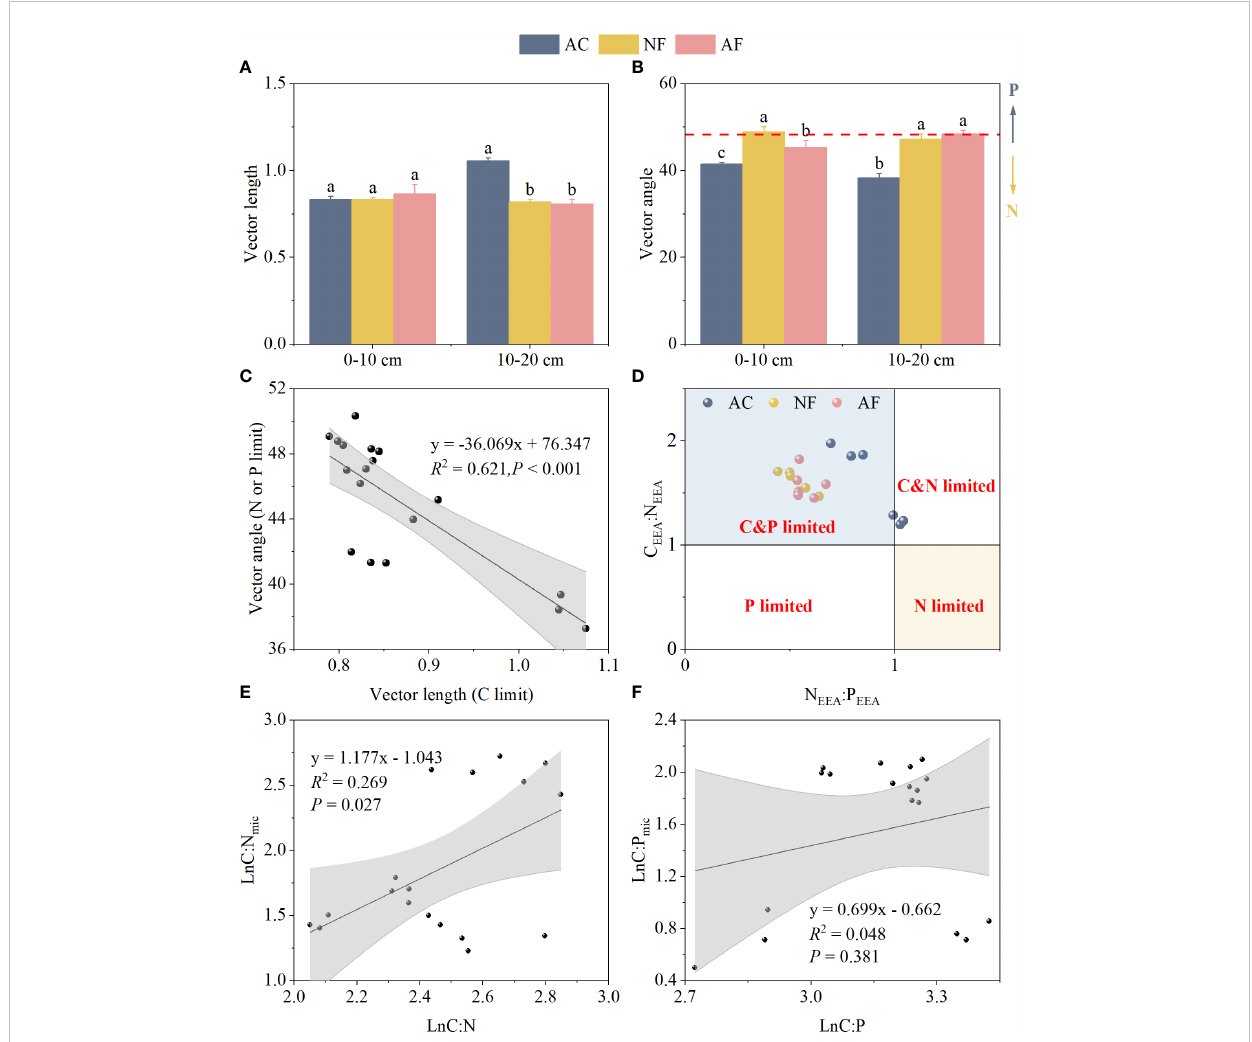
FIGURE 2 Effect of vegetation restoration on soil vector characteristics and microbial homeostasis in abandoned cropland. (A) vector length; (B) vector angle; (C) the relationship of vector length and angle; (D) microbial resource limitation; (E) microbial community homeostasis related to N; (F) microbial community homeostasis related to P. AC, abandoned cropland; NF, naturally restored secondary forest; AF, arti fi cial planted forest; C EEA , the sum of BG, CBH, and BX; N EEA , the sum of NAG and LAP; P EEA , AP activity; C:N, ratio of SOC to STN; C:P, ratio of SOC to STP; C:N mic , ratio of MBC to MBN; C:P mic , ratio of MBC to MBP. Different lowercase letters indicated signi fi cant differences between vegetation restoration types (LSD, P <